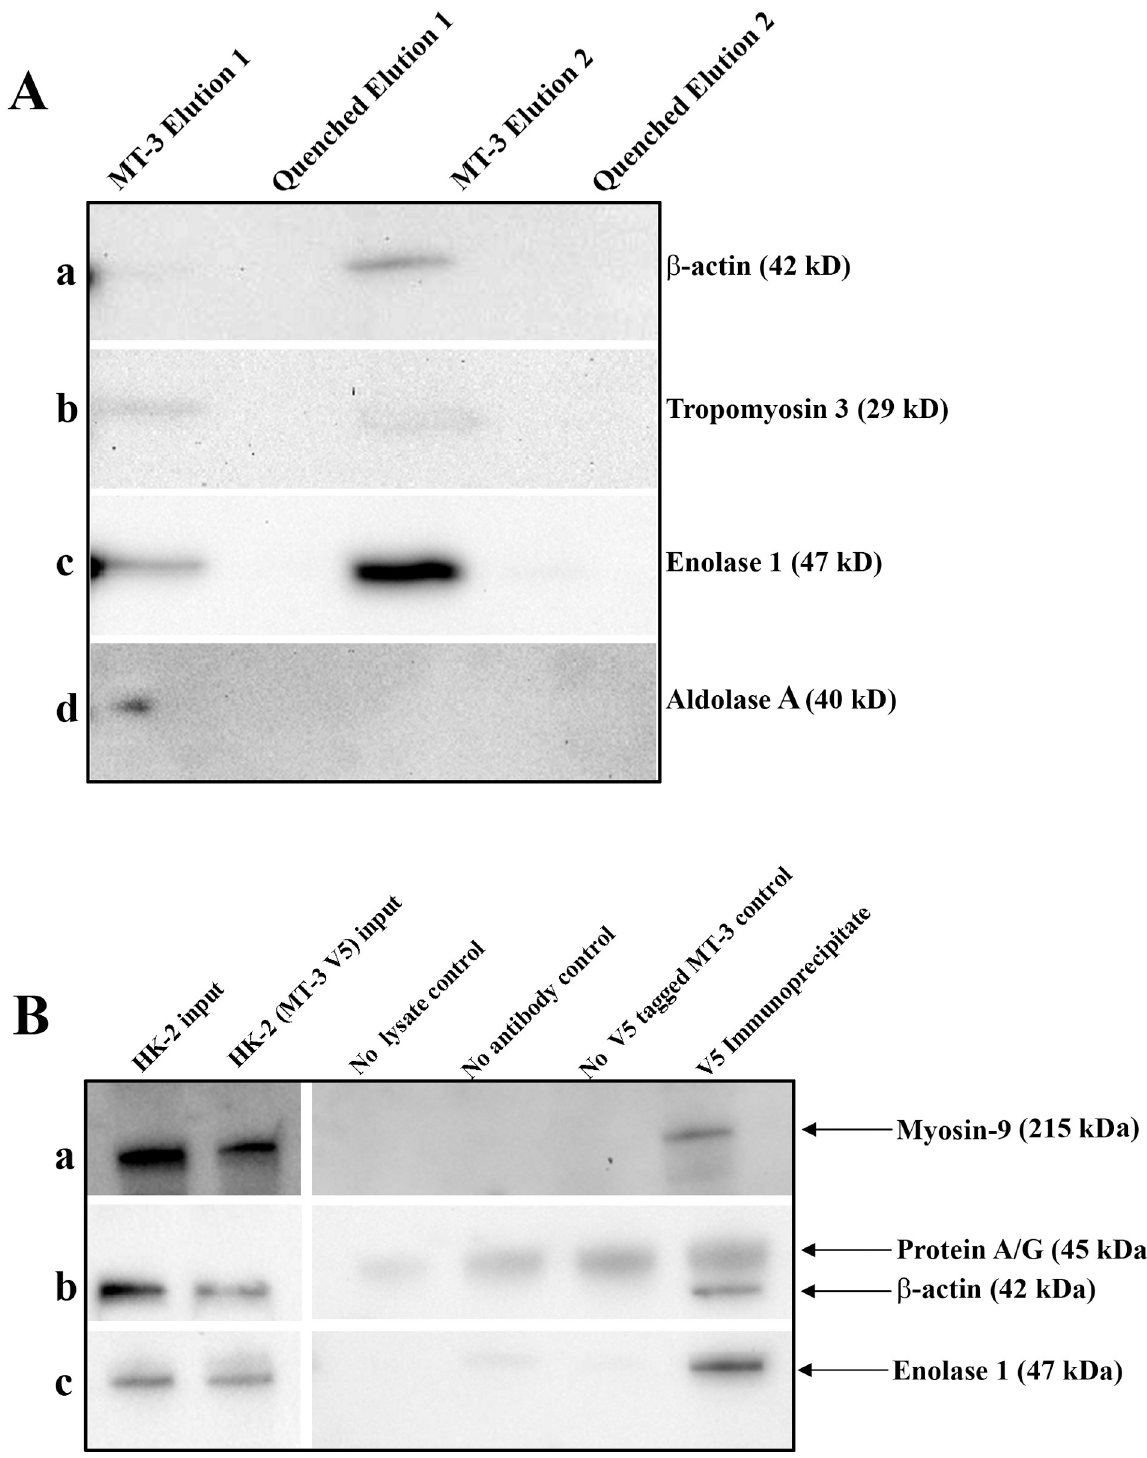
Fig 1. Validation of MT-3 protein interactions by MT-3 mediated pulldown and V5-mediated co-immunoprecipitation. (A). Zn 7 -MT-3 cross-linked agarose beads pulldown proteins isolated from cultured human proximal tubule cells (HK-2) include β -actin (a), tropomyosin 3 (b), enolase 1 (c), and aldolase A (d). (B). MT-3 interacts with myosin-9 (a), β -actin � (b) and enolase 1 (c) in V5-tagged MT-3 expressing proximal tubule cells. To verify the binding of MT-3 to myosin-9, β -actin, and enolase 1 in vitro , the V5 antibody was cross-linked to agarose beads through aldehyde linkage and incubated with HK-2 MT-3-V5 cell lysates. Bound proteins were eluted and detected by western blotting. The